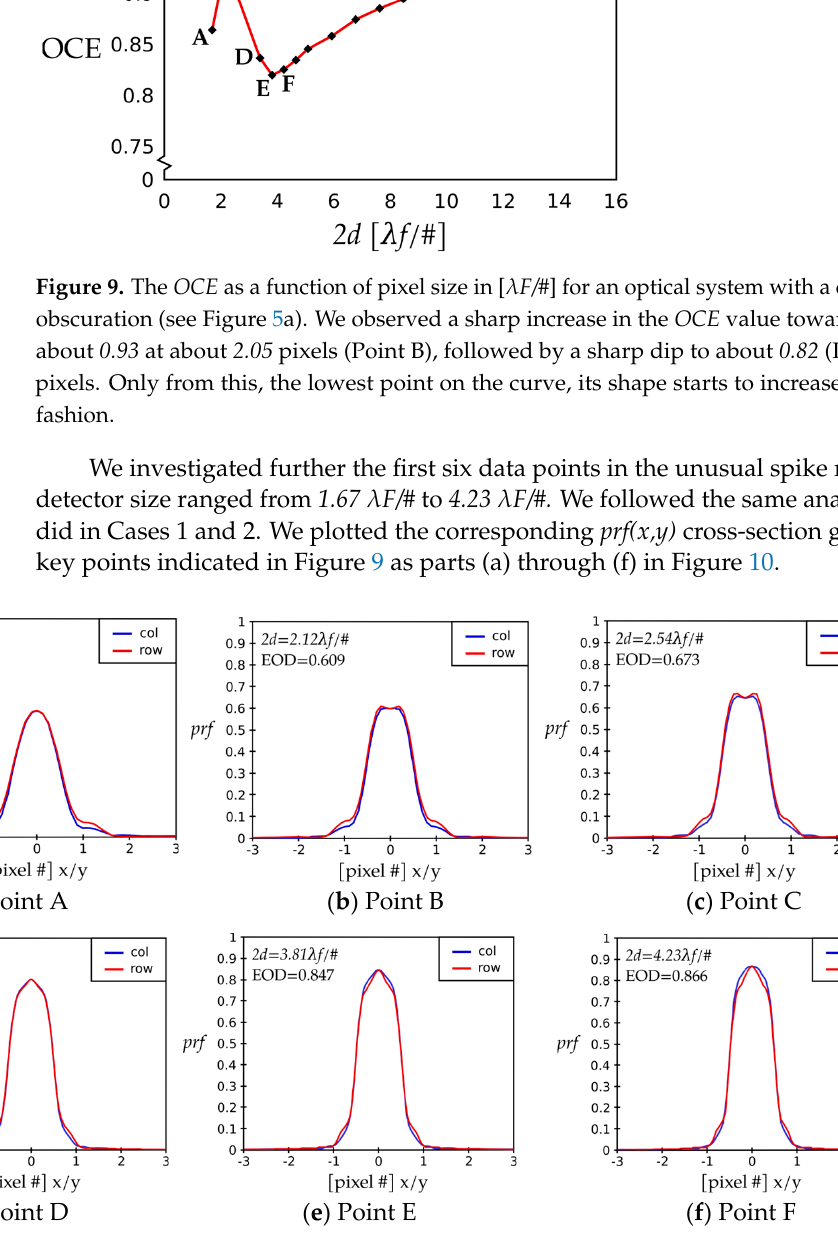
Figure 10. Cross-sections of the prf as a function of two orthogonal directions, x and y, or rows and columns, for the points labeled in Figure 9. We modeled the case where the diameter of the first zero in the ideal diffraction pattern was equal to 2 pixels (in λ F/# units) with the rectangular obscuration of Figure 4a. We observed that the EOD value increased with increasing detector pixel size. EOD is the value of the prf at the pixel center. Concurrently, the shape of the prf(x,y) became modified with increasing detector size from that with explicit support at the base to that with a thin base and without features there.